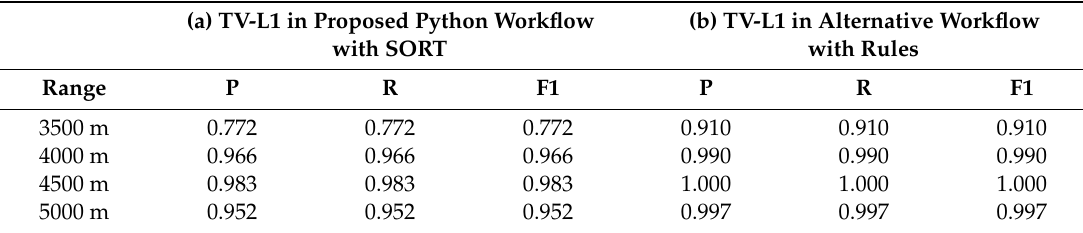
Table 1. Results using the proposed workflow for long-range videos.